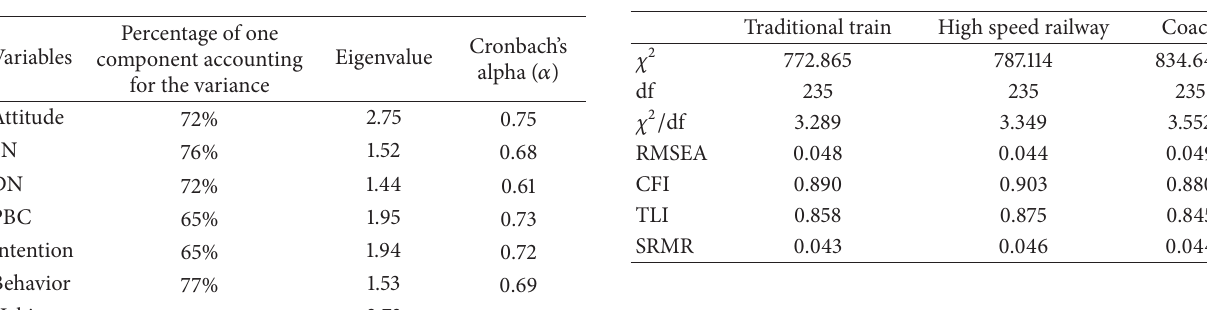
Table 2: Measurements of reliability and validity. Table 3: Goodness-of-fit statistics for MIMIC